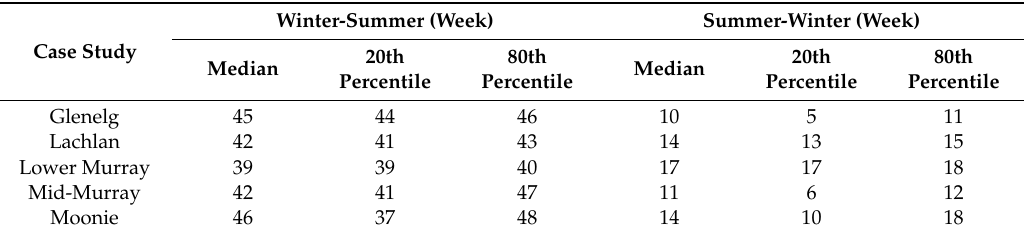
Table 6. Percentile values of the first and last week of the entire time series where 80% of the reaches within a catchment are within the permissible range for virus